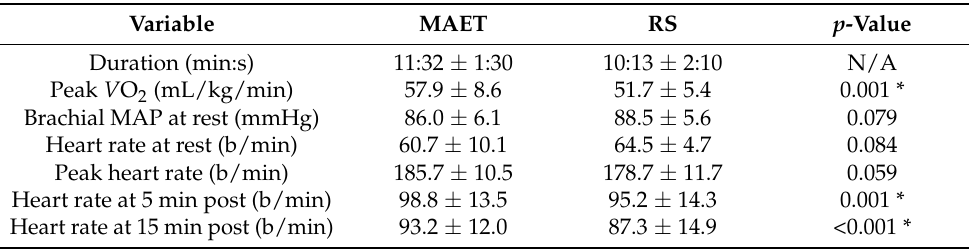
Table 2. Comparison of acute cardiorespiratory and hemodynamic variables in maximal aerobic exercise test and rescue simulation conditions in 38 firefighters.